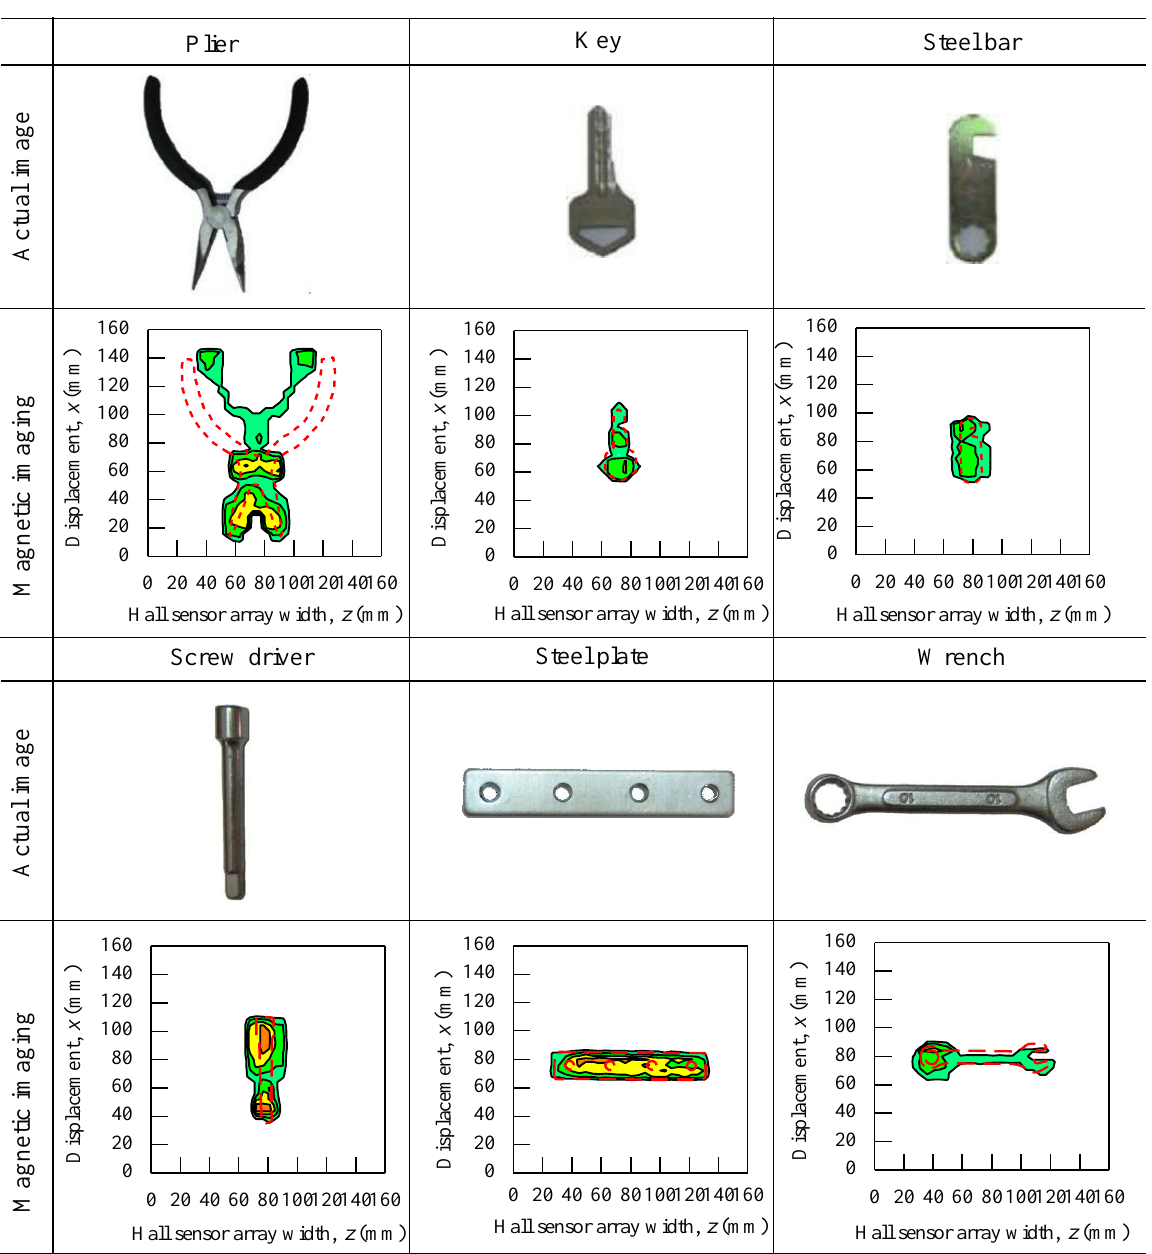
Table 2. Comparison of actual images and magnetic imaging of actual ferrous